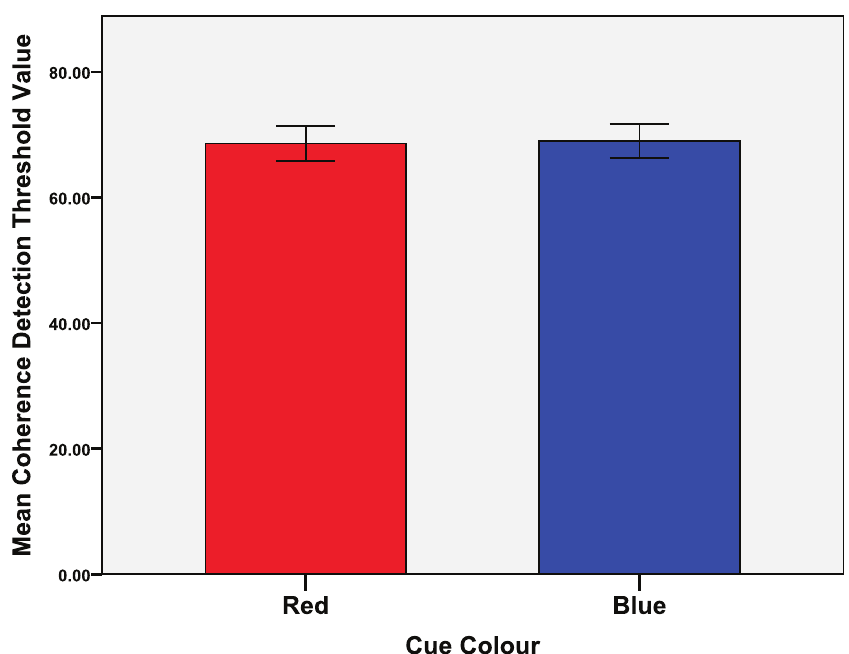
Figure 5. Mean detection threshold values for the first attempts at the coherence (global) task. Error bars indicate the 95% confidence